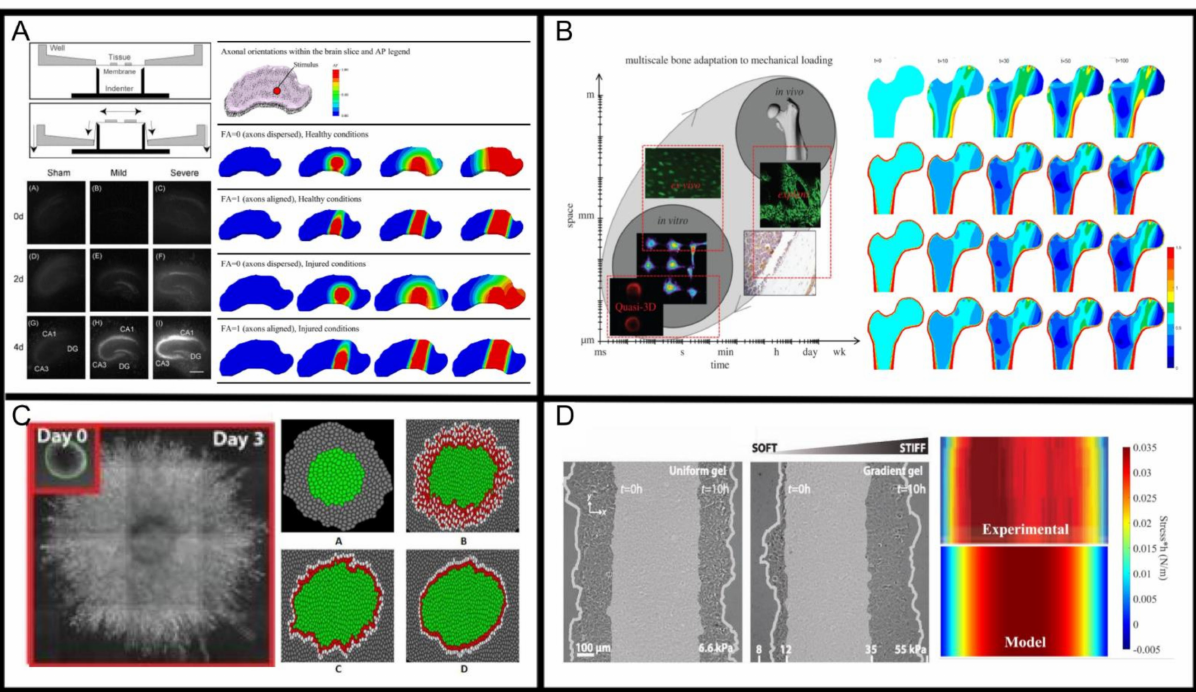
Figure 1. Examples of biological cells and tissue, whose functional response greatly depends on mechanical effects: ( A ) mechano-electrophysiological response in brain tissue, experimental (adapted with permission from [1]) (left) and modelling (adapted with permission from [2]) (right) insights; ( B ) bone adaptation to mechanical loading, experimental (adapted with permission from [3]) (left) and modelling (adapted with permission from [4]) (right) insights; ( C ) cancer cell proliferation and migration depending on mechanical properties of the substrate, experimental (adapted with permission from [5]) (left) and modelling (adapted with permission from [6]) (right) insights; ( D ) durotaxis in epithelial cell migration depending on mechanical properties of the substrate, experimental (adapted with permission from [7]) (left) and modelling (adapted with permission from [8]) (right)